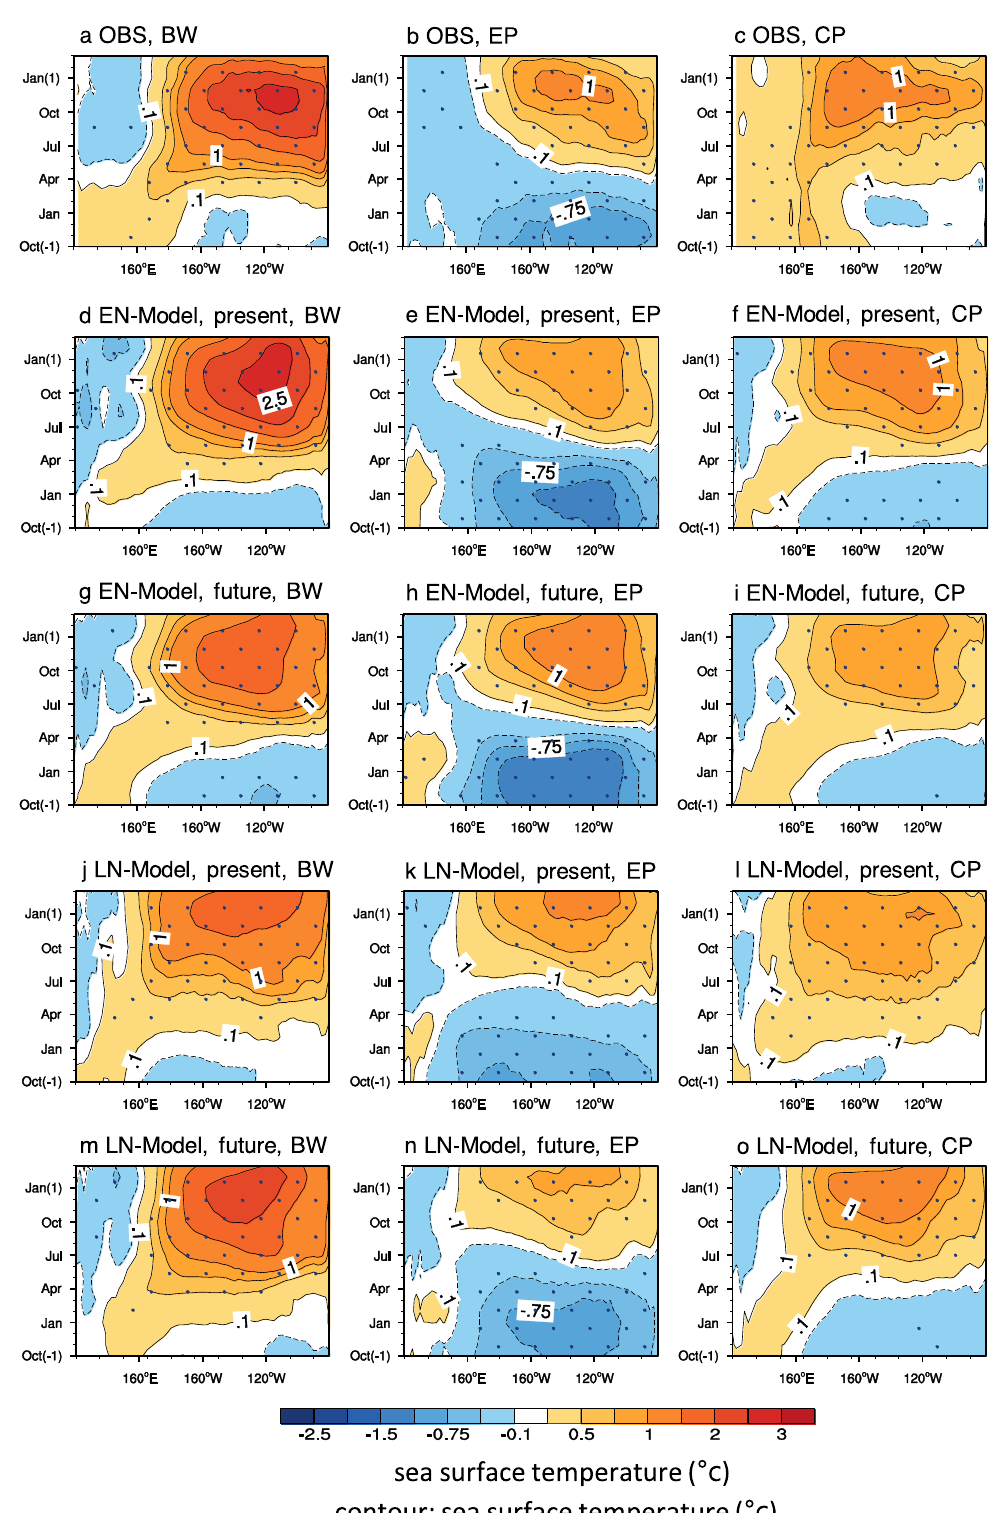
strong, dry anomalies in Australia, the Amazon, and South Africa, and wet anomalies in the central and eastern U.S., East Asia, and East Africa. The LN-Models can capture observed historical precipitation anomalies over both tropical and mid-latitude land areas (Fig. 4c). In tropical oceans, strong, wet anomalies are observed in the central and eastern Paci fi c, whereas dry anomalies